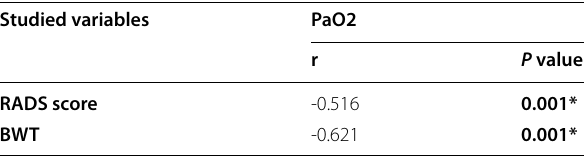
Table 7 Correlation between baseline PaO2 and RADS score and BWT